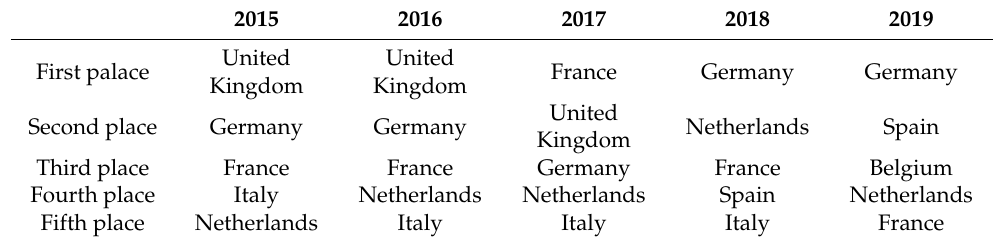
Table 5. European Union countries with maximum photovoltaic installed capacity in years 2015–2019.